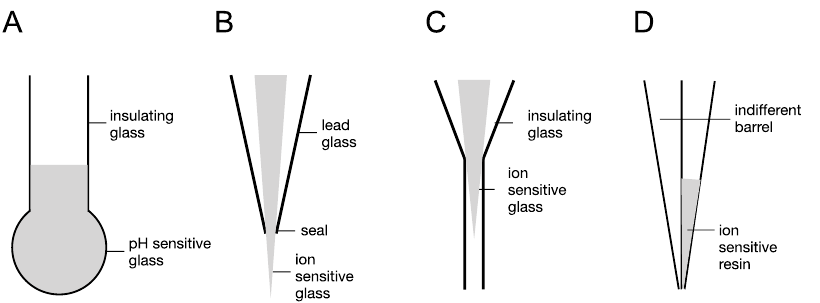
Figure 4. Evolution of ISMs. ( A ) H + -sensitive glass was used to sense pH changes and was the foundation of laboratory pH meters. ( B ) Ion-sensitive glass for microelectrodes that sensed Na + and K + had long protruding tips limiting their use to large cells. ( C ) Recessed tip glass microelectrodes increased the range of cells that could be studied. ( D ) Double barrelled ISMs that used liquid ionophores allowed recording from smaller mammalian cells and increased the number of ions that could be studied.